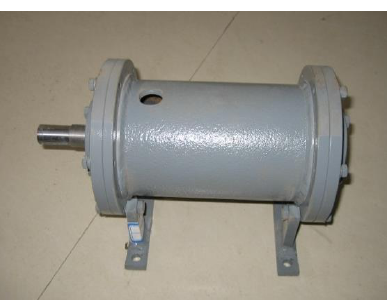
Figure 5. Photograph of the prototype.